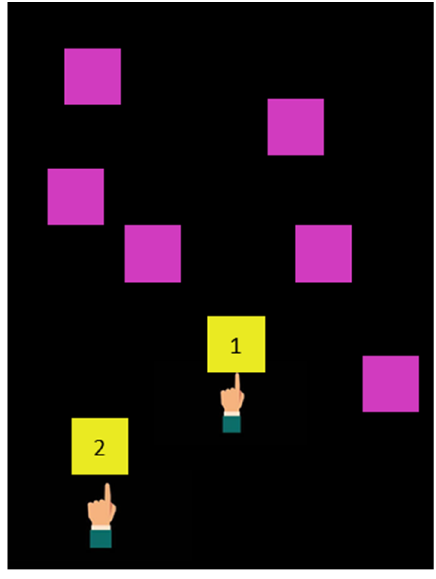
Figure 5. Memory exercise.